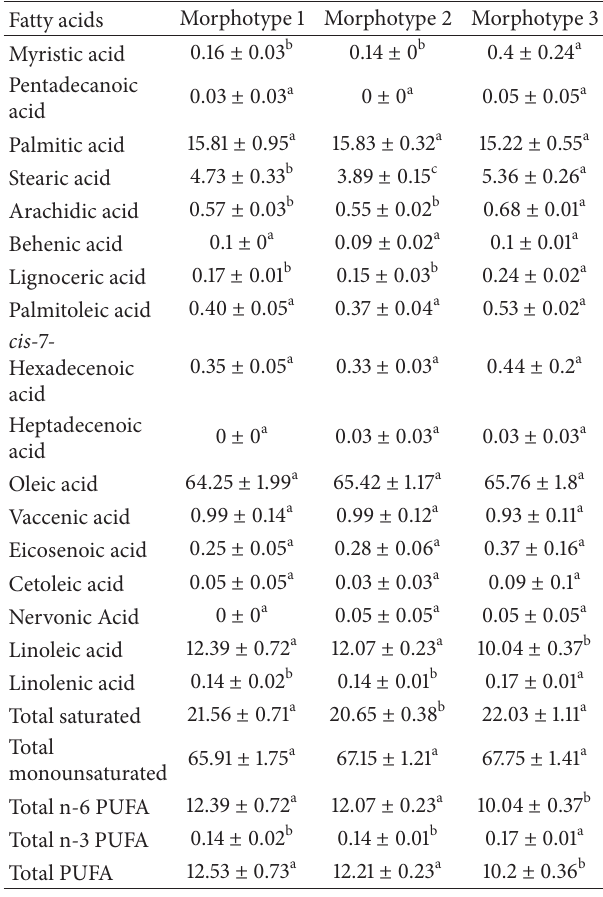
Table 3: Vitamin contents of Cyperus esculentus morphotypes tubers.